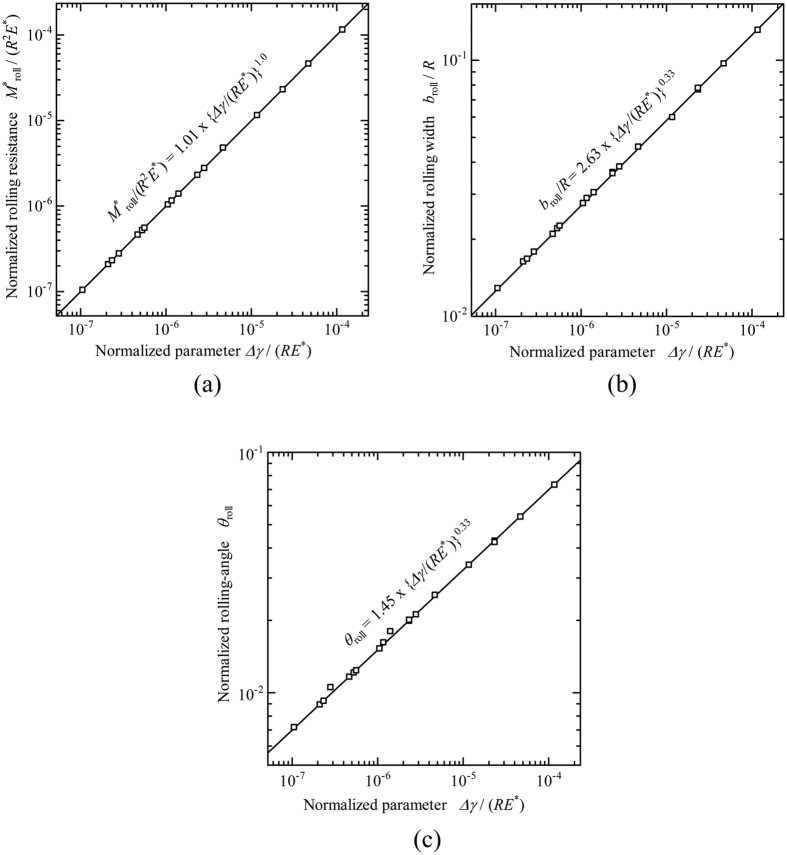
Relations between normalized and dimensionless values ((a) Mroll/R2E*, (b) broll/R, and (c) θroll) and the normalized variable, Δγ/RE*, plotted in logarithmic scales.